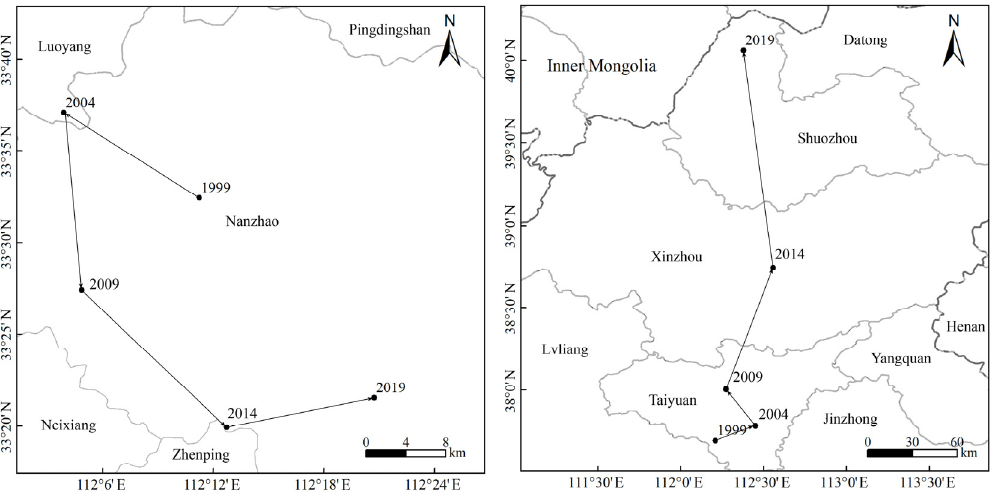
Figure 5. Change of gravity centers of urban construction efficiency and urban carbon emission intensity.